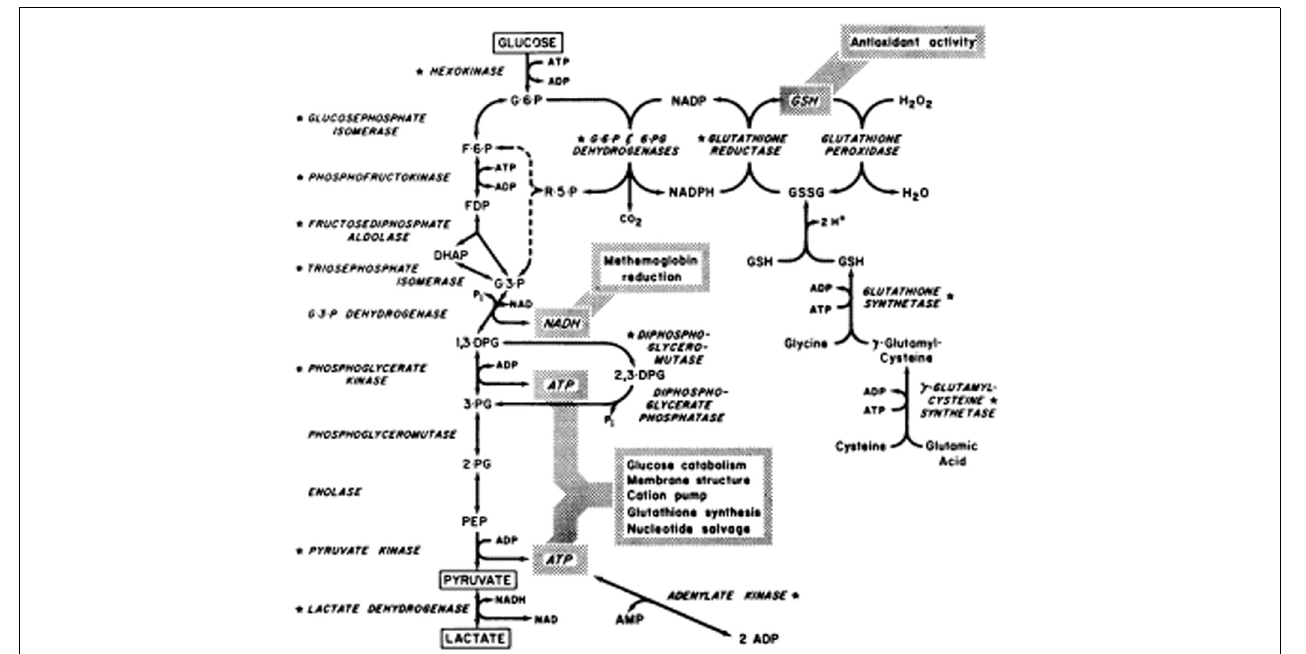
FIGURE 1 | Reprinted from Valentine (1979), with permission from